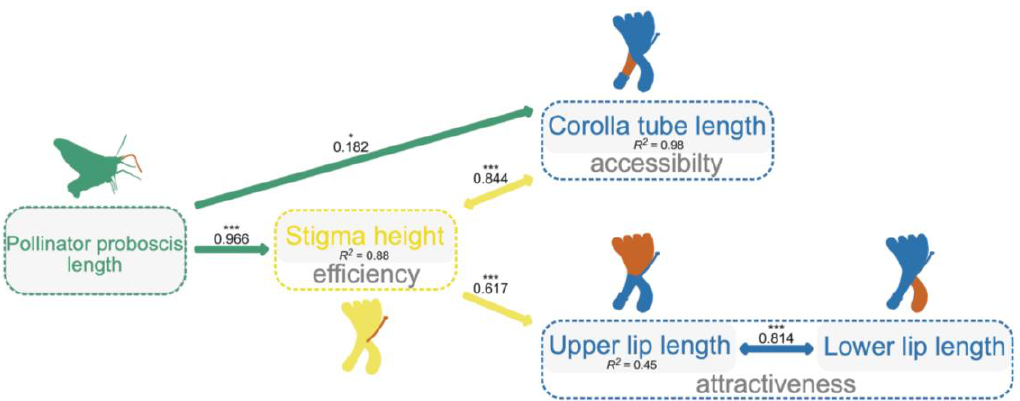
Figure 3. The best phylogenetic structural equation model (PSEM) shows how the pollinator proboscis length integrates floral traits for the studied Lonicera species. Paths between variables (highlighted in orange) included in the best-fitting model are shown. The solid arrows indicate a positive effect of a variable on another. The arrows with double ends indicate correlated errors. Standardized path coefficient was given on each arrow. R 2 for each model is given below the boxes of variables.